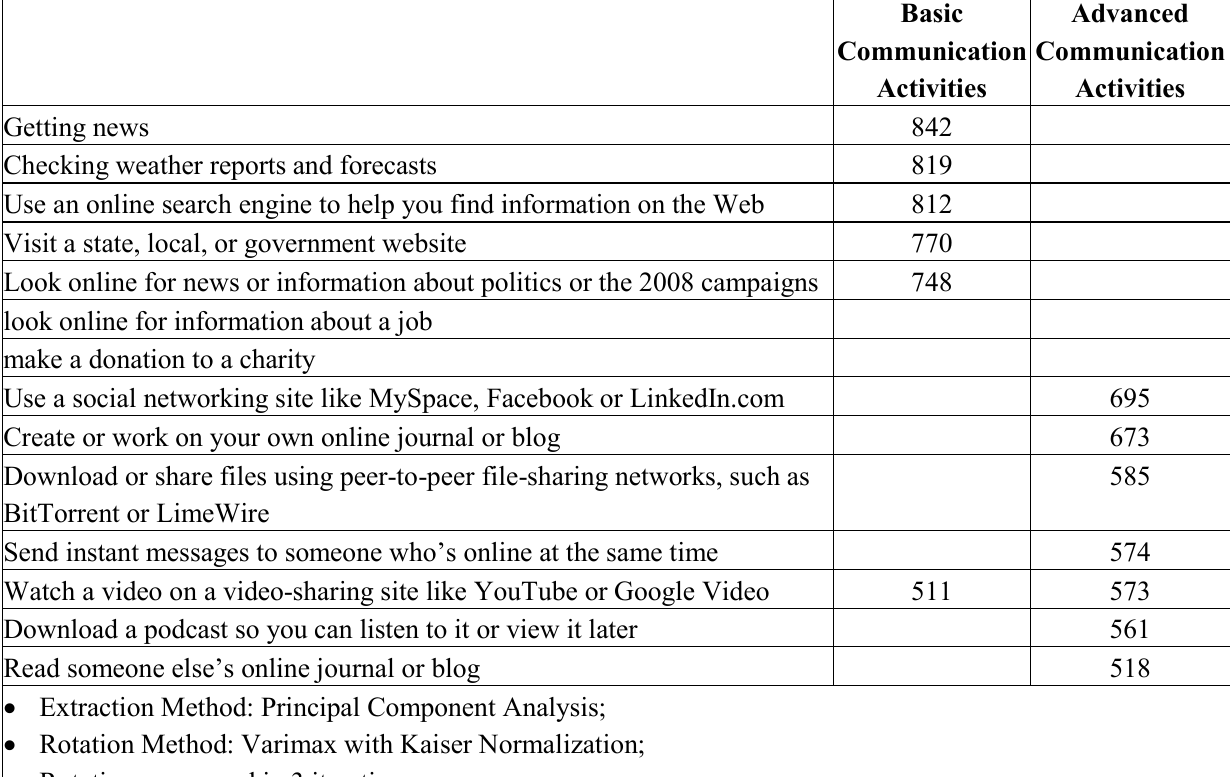
Table 3. Rotated factor loadings for “general internet